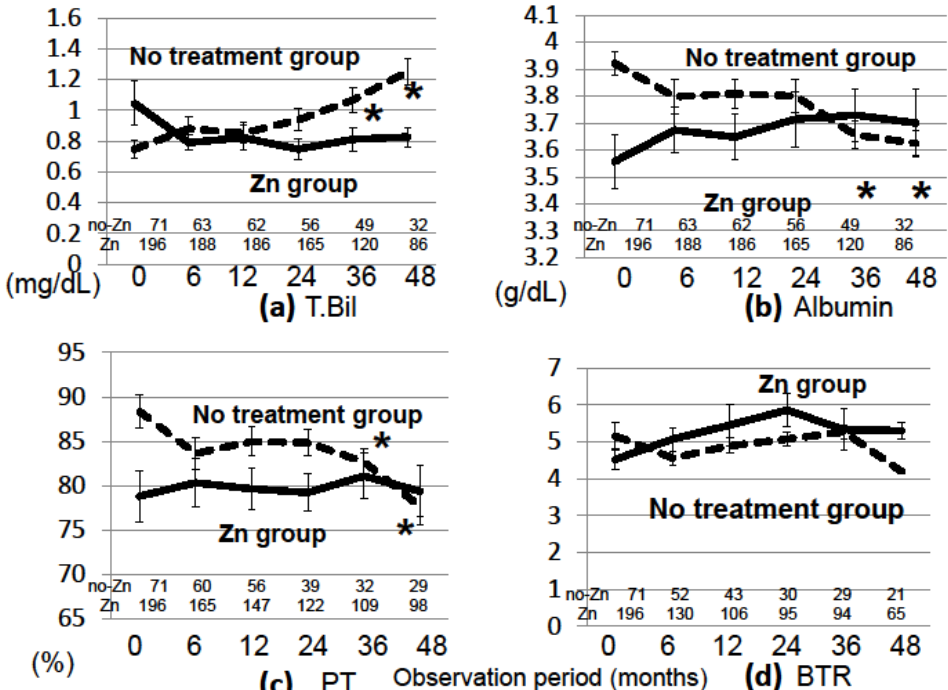
Figure 3. Serial changes in laboratory variables in the Zn- and no Zn-treatment groups. ( a ) Total bilirubin, ( b ) albumin, ( c ) % prothrombin time, ( d ) branched chain amino acids/tyrosine ratio, Asterisks indicate significant differences (*, p < 0.01, compared to the value measured before treatment in each group). The number of patients who underwent blood tests is shown at the bottom of each graph.